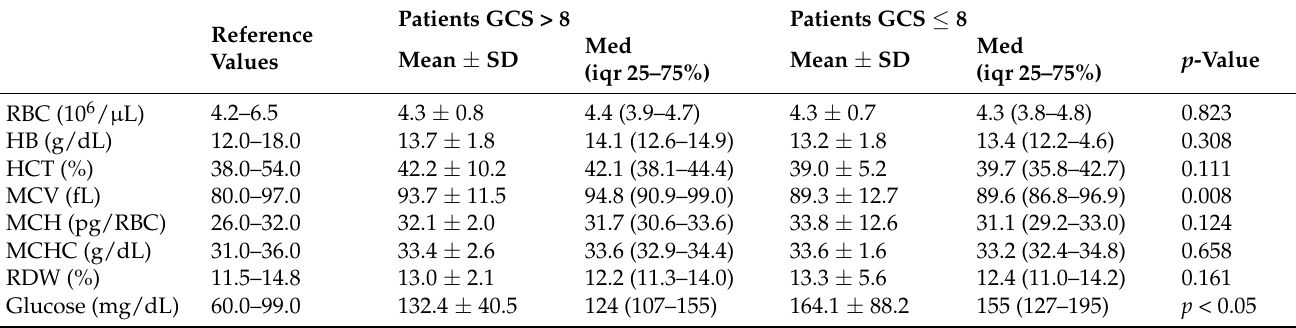
Table 2. Haematological variables and